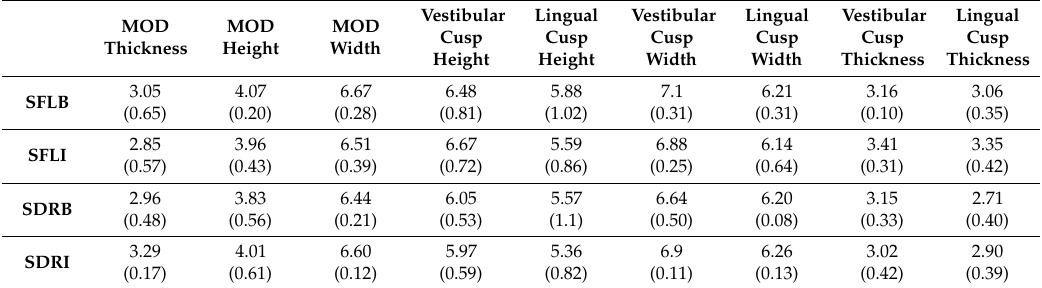
Table 2. Teeth cusps and restorations of mesio-occlusal–distal (MOD) cavity mean dimensions expressed in mm. Numbers in brackets represent the standard